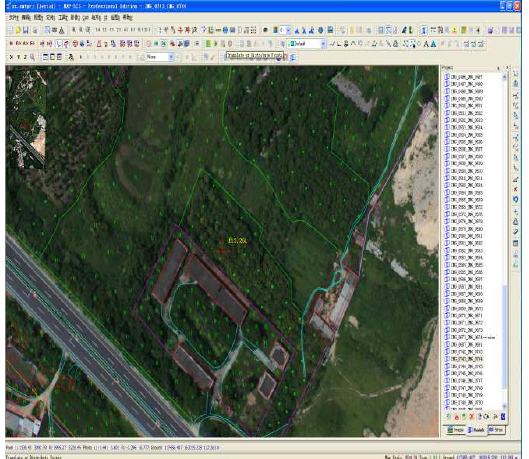
Figure 7 MAP-LCS stereo-mapping software